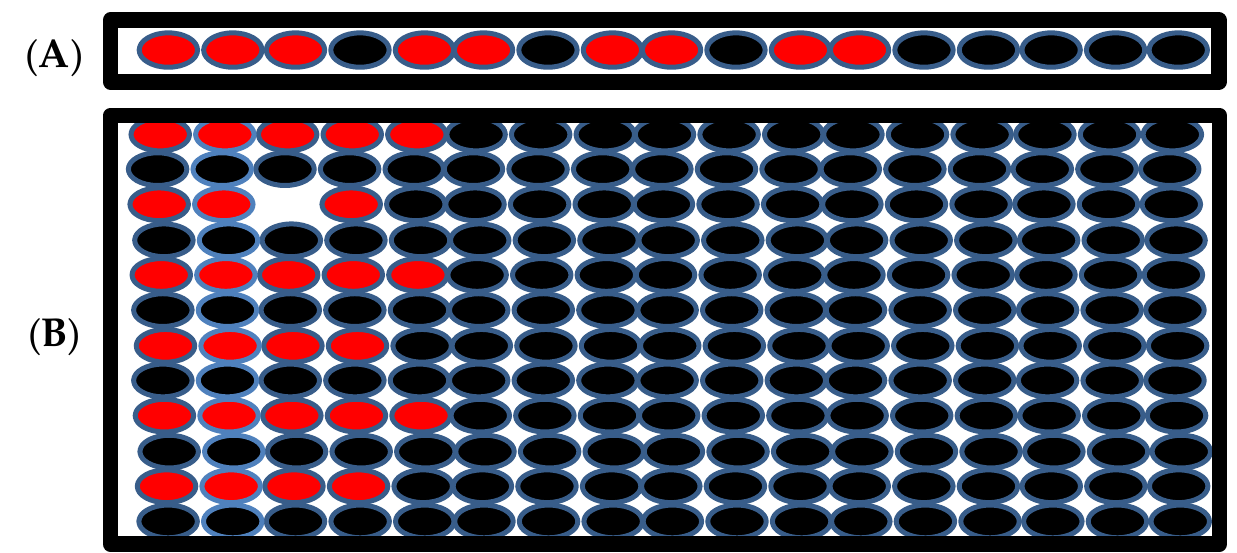
Figure 7. ( A ) The schematic of 1-D tissue where the current is injected into the myocytes with red filling, the myocytes with black filling are the unstimulated myocytes. ( B ). Schematic of the 2-D tissue when the stimulated myocytes are not neighbors but there are some unstimulated myocytes between